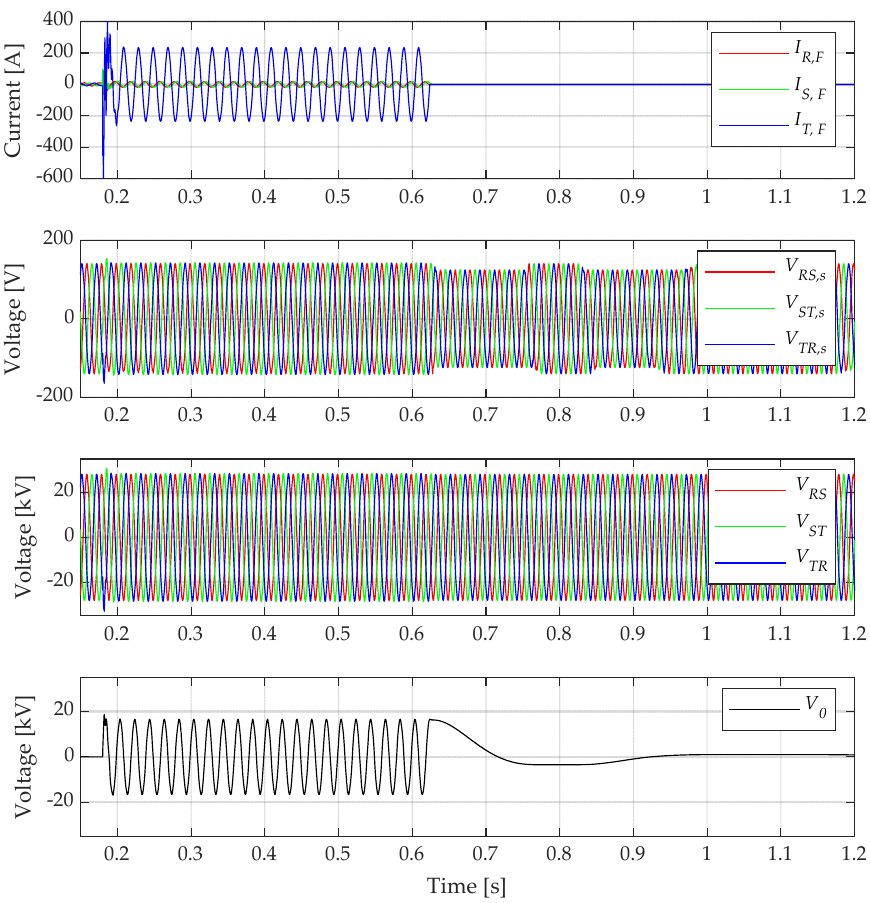
Figure 6. Case 2 (IN system) simulation results, from top to bottom: faulted line currents, line ‐ to ‐ line voltages at the secondary of the VT, line ‐ to ‐ line voltages at the MV busbar, homopolar voltage .